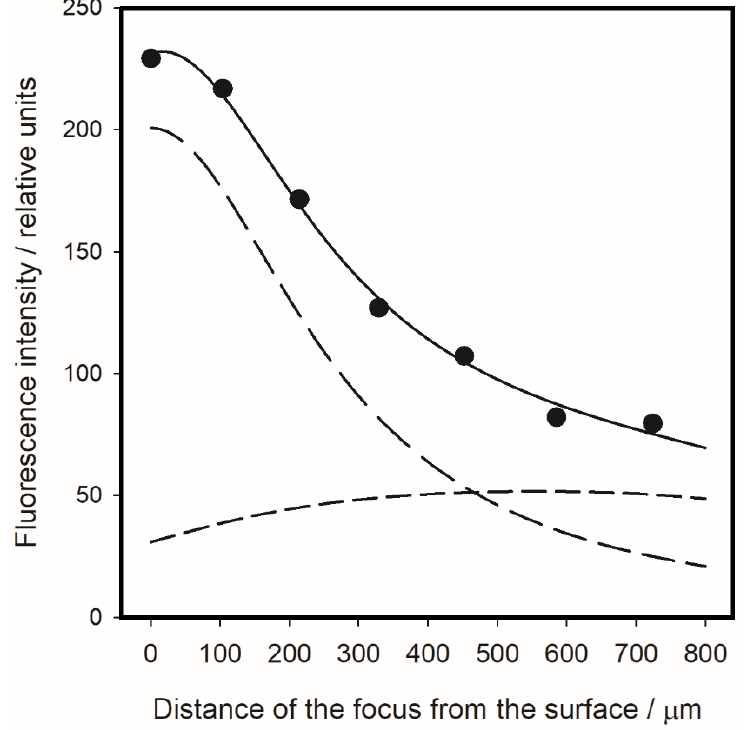
Figure 6. Dependence of the fluorescence intensity at 585 nm on the increasing focus distance from the surface. 5 µL droplet of riboflavin solution in DMSO on the substrate with a 5 nm ms-PTFE overlay (dots). The focus position was recalculated from the position of the objective considering refraction at the spherical droplet surface. Lines show results of the least-square fit: the total fluorescence signal (solid), the signal from the surface (longer dash) and the signal from the droplet volume (shorter dash).